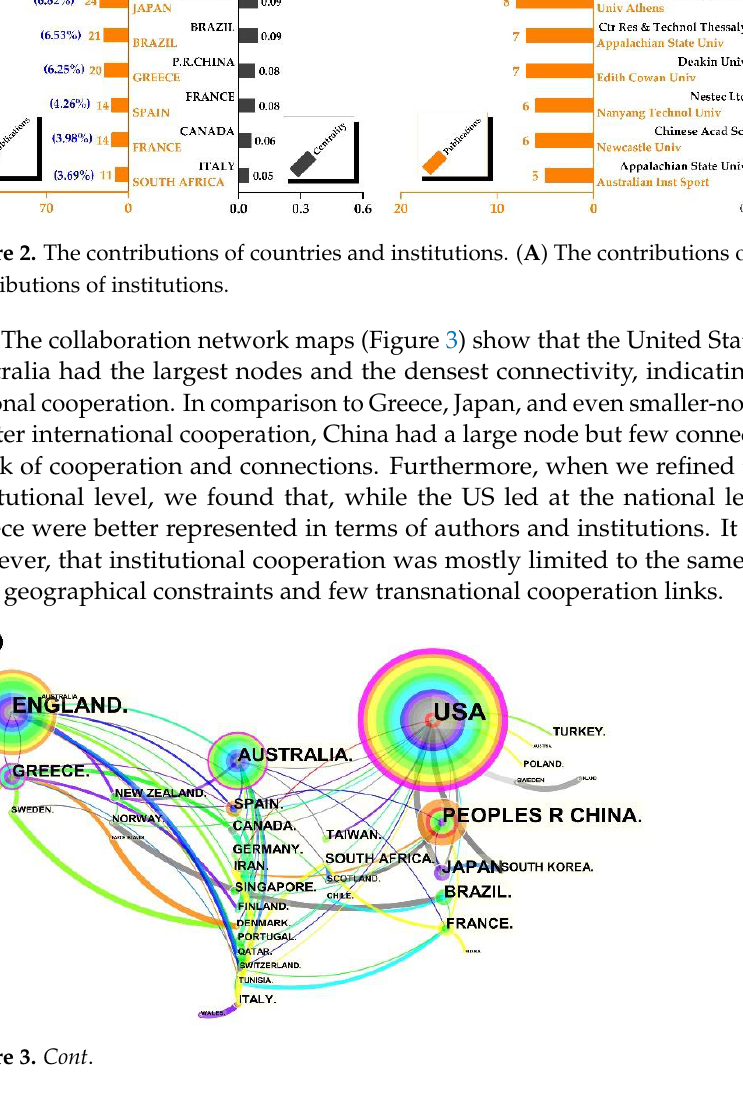
Figure 3. The collaboration network of countries and institutions. ( A ) The collaboration network of countries; ( B ) the collaboration network of institutions. 3.3. Author and Co-Cited Authors There were 590 authors who contributed to the total number of publications, with the top 10 authors having a total of 89 publications (Figure 4A). Only four authors had at least 10 publications, with Howatson having the most (14), followed by Jamurtas (13), Fatouros (11), and Nikolaidis (10). Among the top ten co-cited authors (Figure 4B), Clarkson was the only author in the top ten with more than 100 co-cited records (120), followed by Nosaka (88), Howatson (81), Armstrong (62), and Friden (48). Notably, Connolly had the highest centrality (0.24) with 35 co-citation counts, followed by Friden (0.17), Coombes (0.16), Proske (0.15), and Armstrong (0.14). Surprisingly, Bradford ’ s centrality was 0.14 with only two co-citations, but one of his earlier methodological studies on the rapid and sensitive quantification of protein utilization had been cited over 200,000 times in WoS [28].